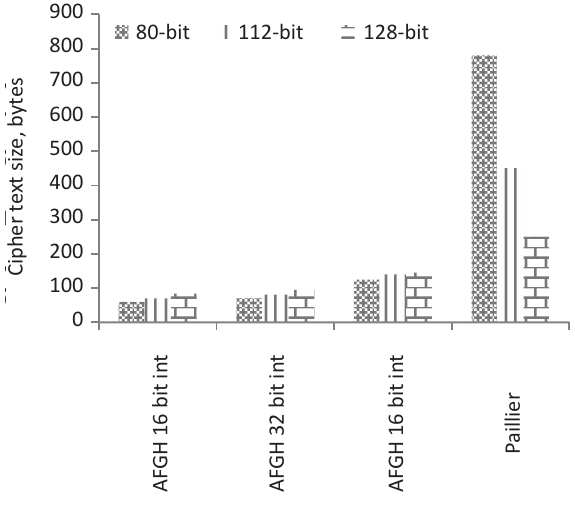
Fig. 6. Ciphertext size – Paillier vs. AFGH algorithm. Healthcare industry in